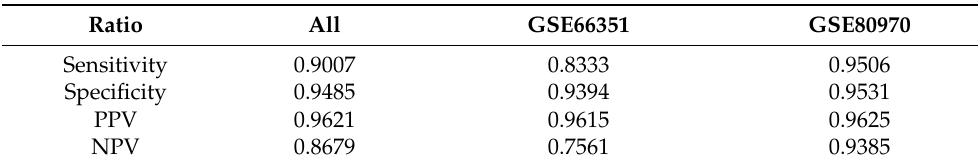
Table 9. Classification ratios (out-of-sample), including positive predictive value (PPV) and negative predictive ratio